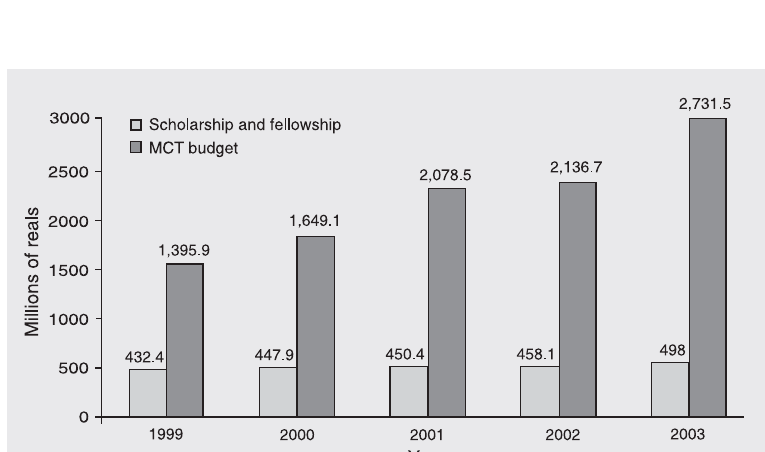
Figure 4. Ministry of Science and Technology (MCT) budget between 1999 and 2003, and the amount spent on scholarships and fellowships (original data source: Ministry of Science and Technology, http://www.mct. gov.br/estat, and CNPq, http://fomentonacional.cnpq.br/